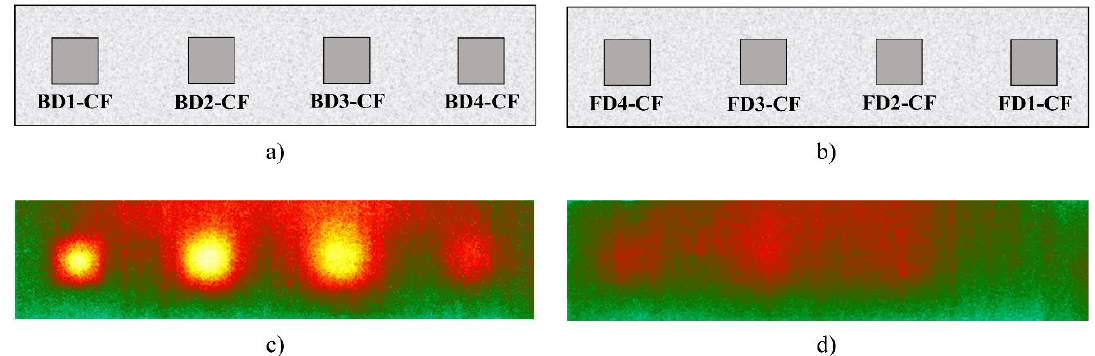
Figure 5. ( a ) Defects locations from back-face; ( b ) defects locations from front-face; ( c ) thermal image after 10 min of cooling under 15-min heating from back-face; ( d ) thermal image after 40 min of cooling under 25 min heating from front-face.